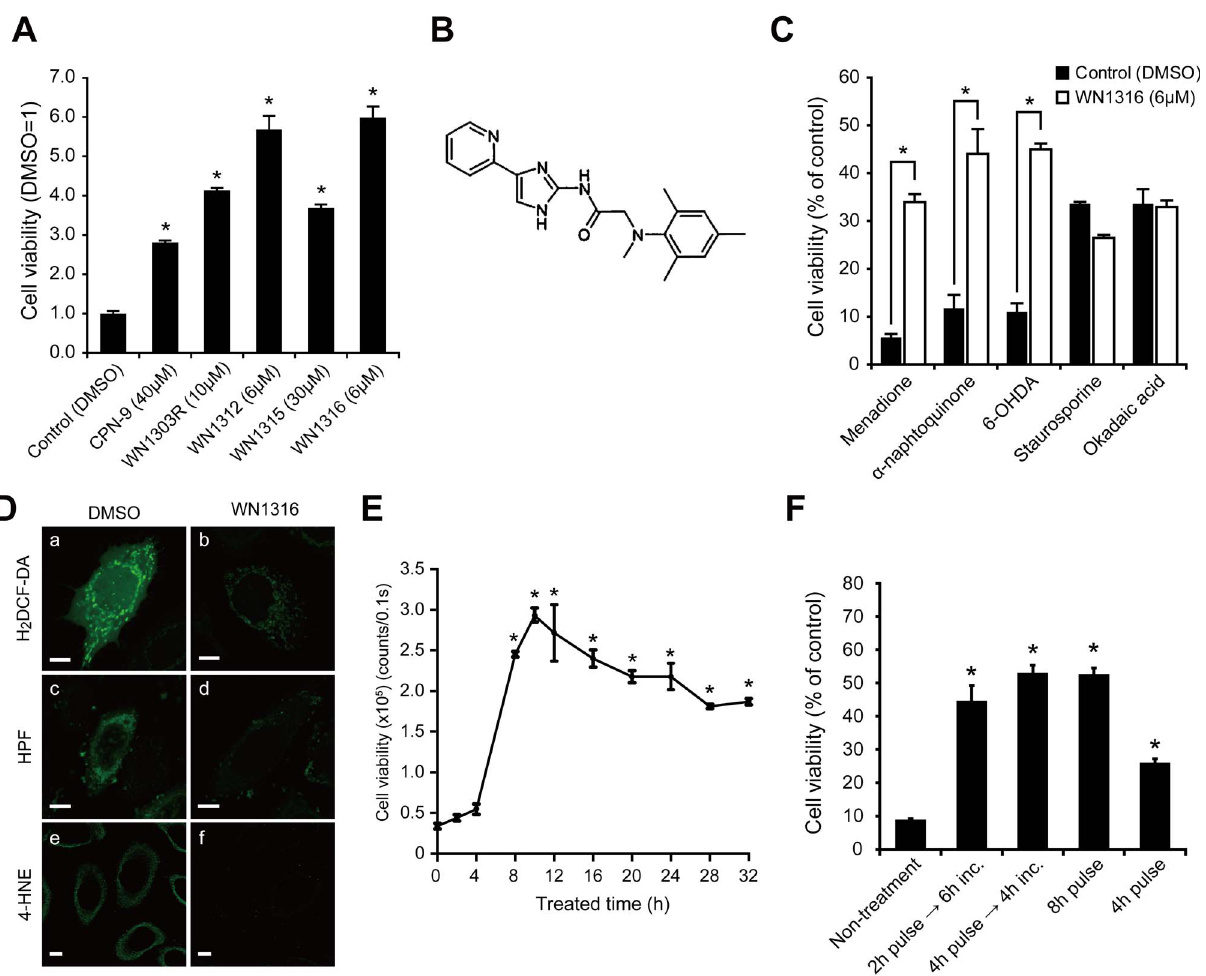
Figure 1. WN1316 selectively protects neuronal cells from the oxidative damage. (A) Effect of compounds against oxidative stress-induced cell death. Differentiated SH-SY5Y cells were treated with compounds or dimethyl sulfoxide (DMSO). After 24 h, cells were exposed to 60 m M menadione for 4 h. The cell viability was measured by AlamarBlue assay. The cell viability was expressed as a fold induction after the treatment with compounds compared with vehicle control (DMSO). Data are expressed as mean 6 SD (n=4). * p , 0.001 by one-way ANOVA with Dunnett’s post hoc test compared with DMSO-treated control. (B) Chemical structure of WN1316; 2-[mesityl(methyl)amino]-N-[4-(pyridin-2-yl)-1H-imidazol-2-yl] acetamide trihydrochloride. (C) Effect of WN1316 against various cytotoxins. Differentiated SH-SY5Y cells were pretreated with 6 m M WN1316 or DMSO for 8 h at 37 u C. The appropriate amount of each cytotoxin, which includes free radical generating compounds [menadione, a -naphtoquinone, 6-hydroxydopamine (6-OHDA)], protein kinase inhibitor (staurosporine), or phosphatase inhibitor (okadaic acid), was added, and incubated for another 4 to 6 h as described in Material & Methods. The cell viability was measured by AlamarBlue assay. Data are expressed as mean 6 SD (n=4). * p , 0.001 by one-way ANOVA with Dunnett’s post hoc test compared with DMSO-treated control. (D) Representative image of the total intracellular ROS (a and b), ? OH (c and d), and the intracellular 4-HNE (e and f) levels in HeLa cells after oxidative insult. Cells were treated with DMSO (a, c, and e) or 10 m M WN1316 (b, d, and f) for 8 h and then loaded with 10 m M 2 9 ,7 9 -dichlorodihydrofluorescein diacetate (H 2 DCF-DA) (a and b) or 100 m M hydroxyphenyl fluorescein (HPF) (c and d) for 30 min, followed by the exposure to 60 m M menadione for 1 h or 0.1 mM FeSO 4 /0.2 mM H 2 O 2 for 1 h, respectively. For immunocytochemistry, cells were treated with DMSO or 10 m M WN1316 for 8 h, followed by the exposure to 60 m M menadione for 1 h, and immunostained with anti-4-HNE antibody (green). The fluorescent images were obtained by using a confocal microscope. Scale bars indicate 10 m m. (E) Treatment time of WN1316 on the cytoprotection. Differentiated SH-SY5Y cells were incubated with 6 m M WN1316 for the indicated times, and then treated with 60 m M menadione for 4 h. The cell viability was determined by AlamarBlue. Data are expressed as mean 6 SD (n=4). * p , 0.001 by one-way ANOVA with Dunnett’s post hoc test compared with DMSO-treated control. (F) Treatment time of WN1316 on the cytoprotection. Differentiated SH-SY5Y cells were incubated with 6 m M WN1316 for the indicated times, and then treated with 60 m M menadione for 4 h. The cell viability was determined by AlamarBlue. Data are expressed as mean 6 SD (n=4). * p , 0.001 by one-way ANOVA with Dunnett’s post hoc test compared with DMSO-treated control. doi:10.1371/journal.pone.0087728.g001 indicate that WN1316 activates and/or stimulates de novo synthesis differentiated SH-SY5Y cells for longer than 8 h was required for of the endogenous proteins conferring selective protection from AOND activity (Figure 1E). In another way, incubation of the cells oxidative stress-induced damages rather than acting as a radical with WN1316 for 2 to 4 h followed by 6 to 4 h of a chase scavenger. incubation without the compound was essential to achieve a maximum cytoprotection against 60 m M menadione mediated oxidative stress induced cell death (Figure 1F). These results